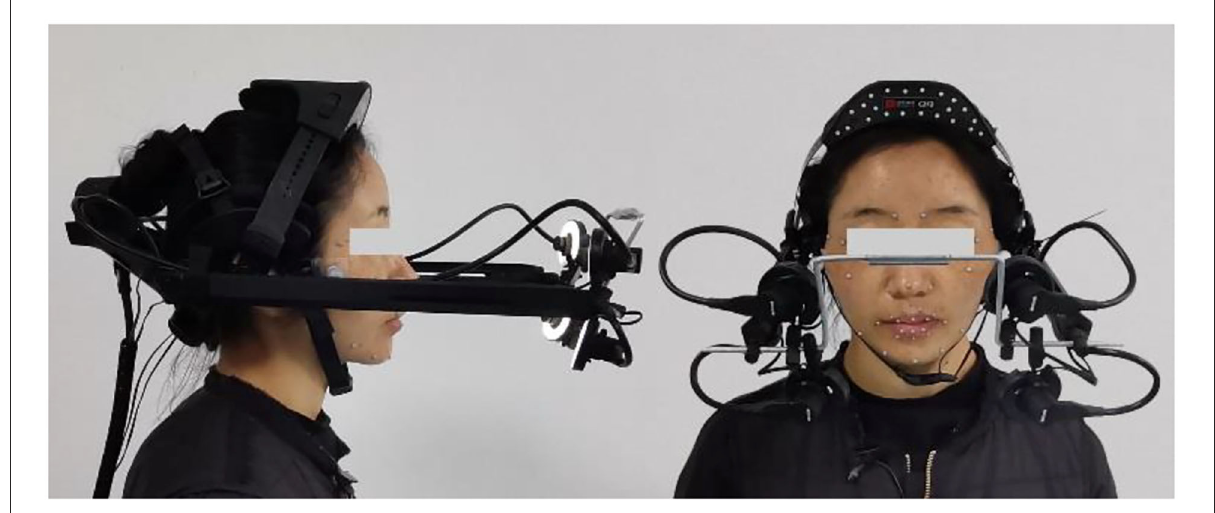
FIGURE1 Collect the dynamic data of lip shape of the speaker lmc.